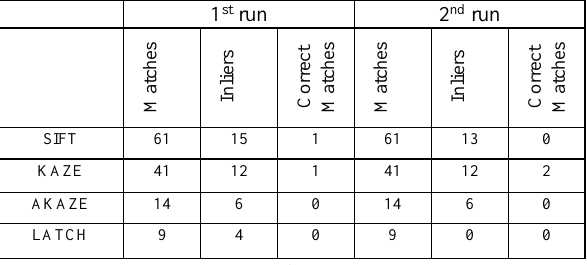
Table 2 Matching results of scene 1 between aerial and panoramic image of the 1st and 2nd iteration